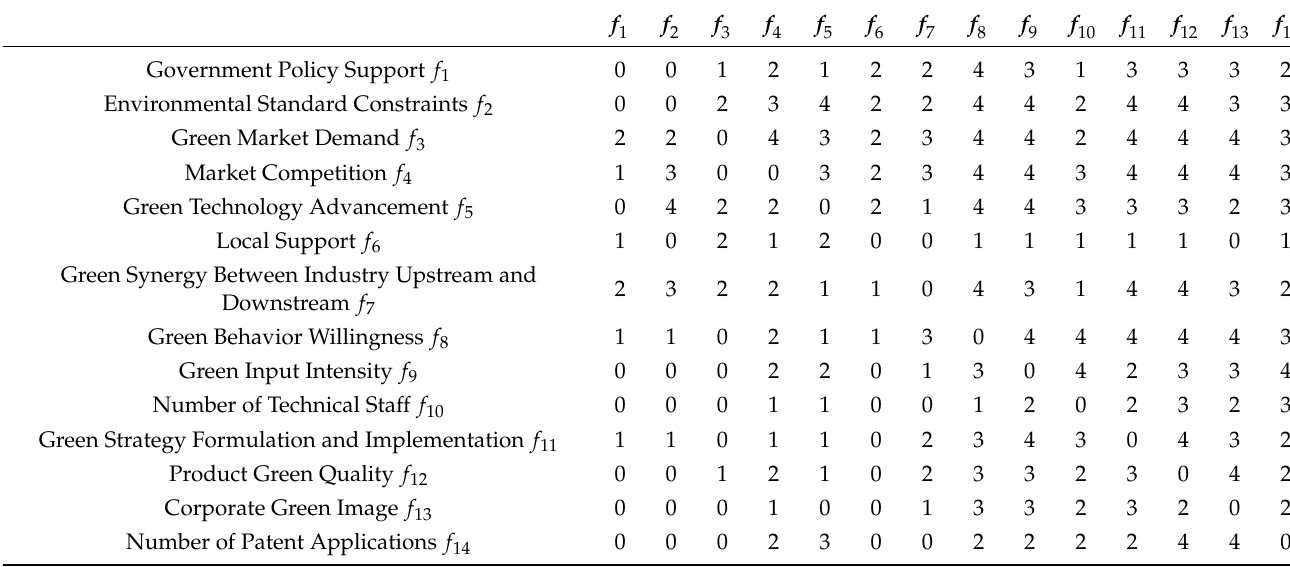
Table 3. The direct impact matrix A.